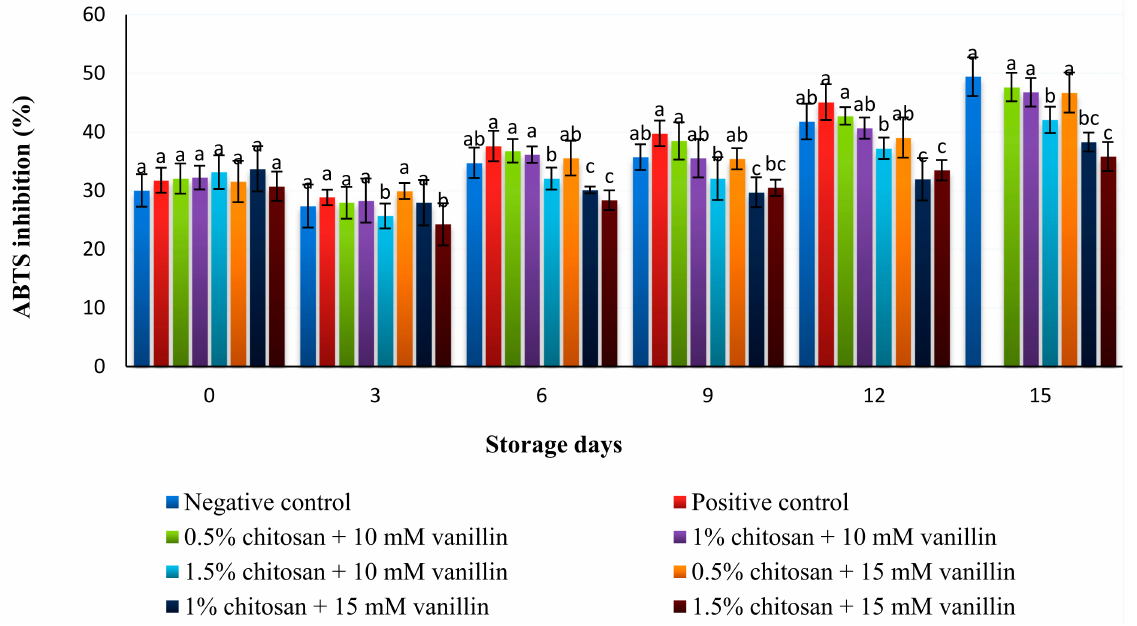
Figure 7. Effects of coating treatment on ABTS in Fusarium oxysporum inoculated tomato fruit stored for 15 days at 26 ± 2 ◦ C and 60 ± 5% relative humidity. Mean values in a column followed by different letters for each storage day differed significantly by LSD at p ≤ 0.05. Vertical bars indicate standard error of means ( n = 24). Table 5. Pearson’s correlation coefficients for TPC, DPPH, ABTS and FRAP of Fusarium oxysporum